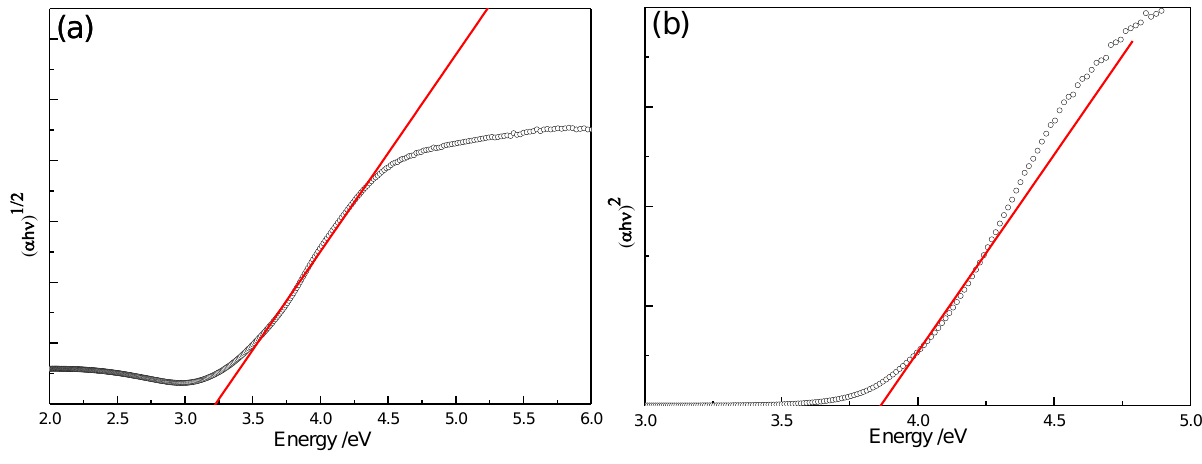
Table 2. Band gap of TiO